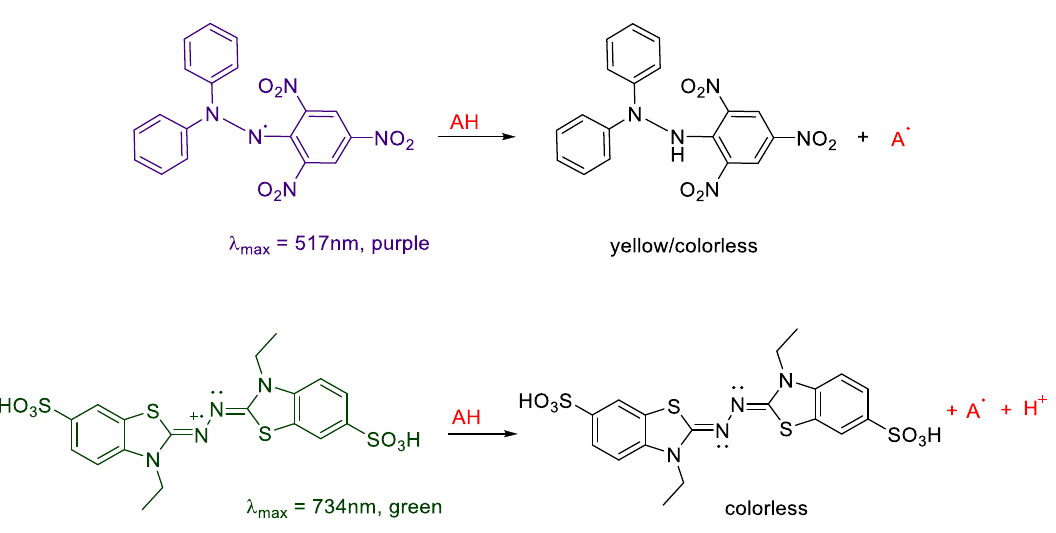
Figure 6. DPPH• hydrogen atom abstraction (HAT) and ABTS+• single electron transfer (SET) Figure 6. DPPH • hydrogen atom abstraction (HAT) and ABTS + • single electron transfer (SET) reactions reactions with a generic antioxidants species (AH). with a generic antioxidants species